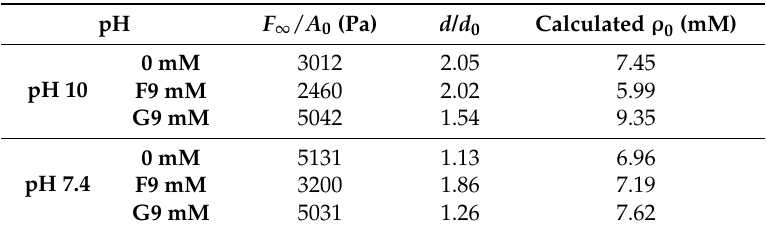
Table 1. Measured plateau engineering stresses, F ∞ / A i , and active chain densities, ρ 0 , calculated using Equation (5) using data from Figure 3. Compression ratio is α =